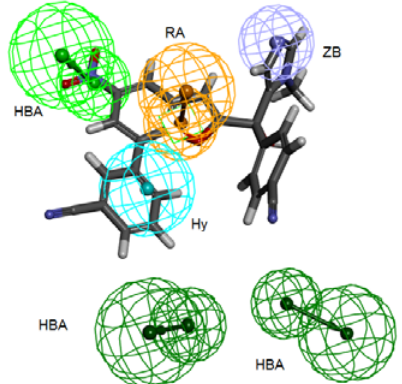
Figure 6. 2ZIS-NH8903 overlaid on pharm-B hypothesis. HY; hydrophobic, RA; ring aromatic, HBA; hydrogen bond acceptor, ZB zinc